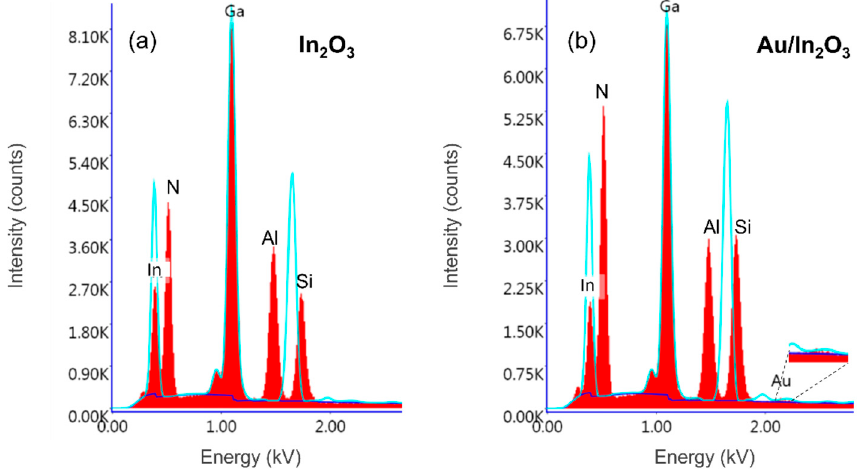
Figure 2. EDS spectrum of ( a ) In 2 O 3 and ( b ) Au/In 2 O 3 sensors. Small peak at 2.1 kV for Au/In 2 O 3 sensors reveals the presence of deposited Au.